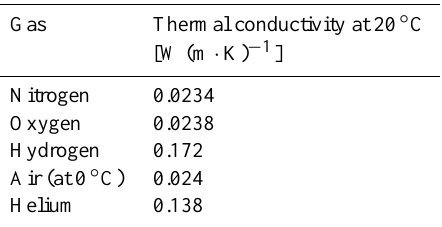
Table 1. Examples of the thermal conductivity of different gases. Data from Young and Sears